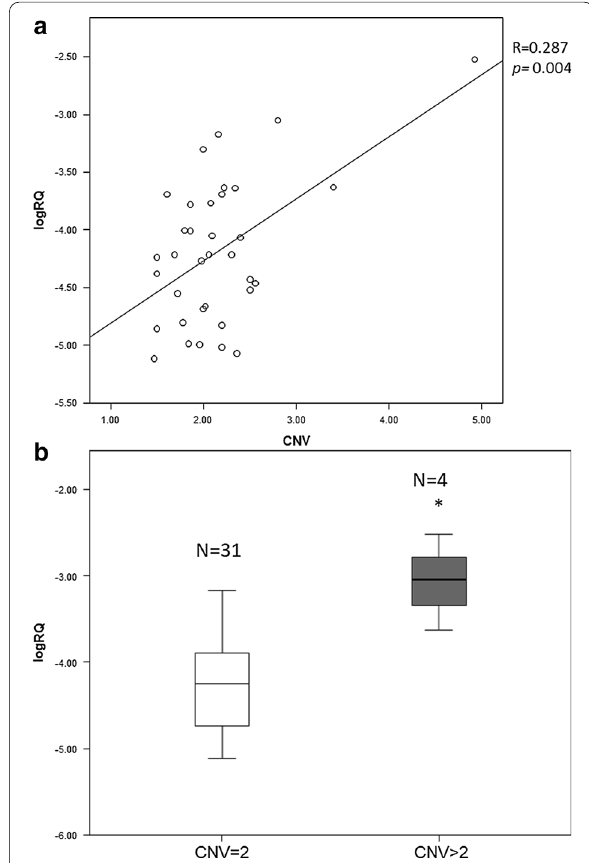
Fig. 1 Scatter plots and box plot illustrating respectively the associations between exact CNVs and E2F1 expression ( a ) and the different E2F1 expression between patients with CNV CNV > 2 (N 4) in somatic tissue ( b ). * p value < =